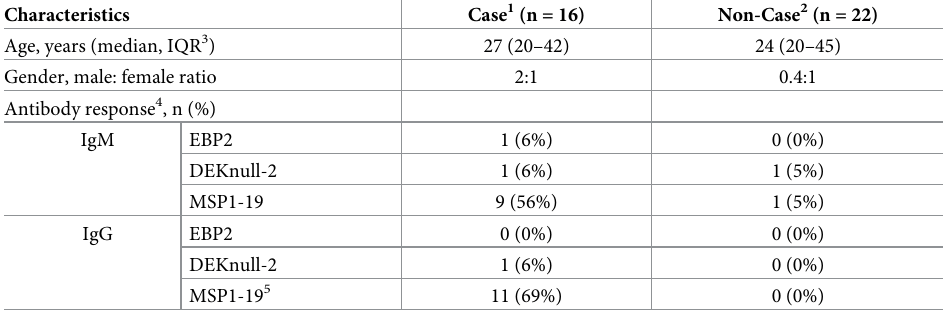
Table 1. Demographic, epidemiological, and immunological data of individuals in the P . vivax malaria outbreak area at enrollment.